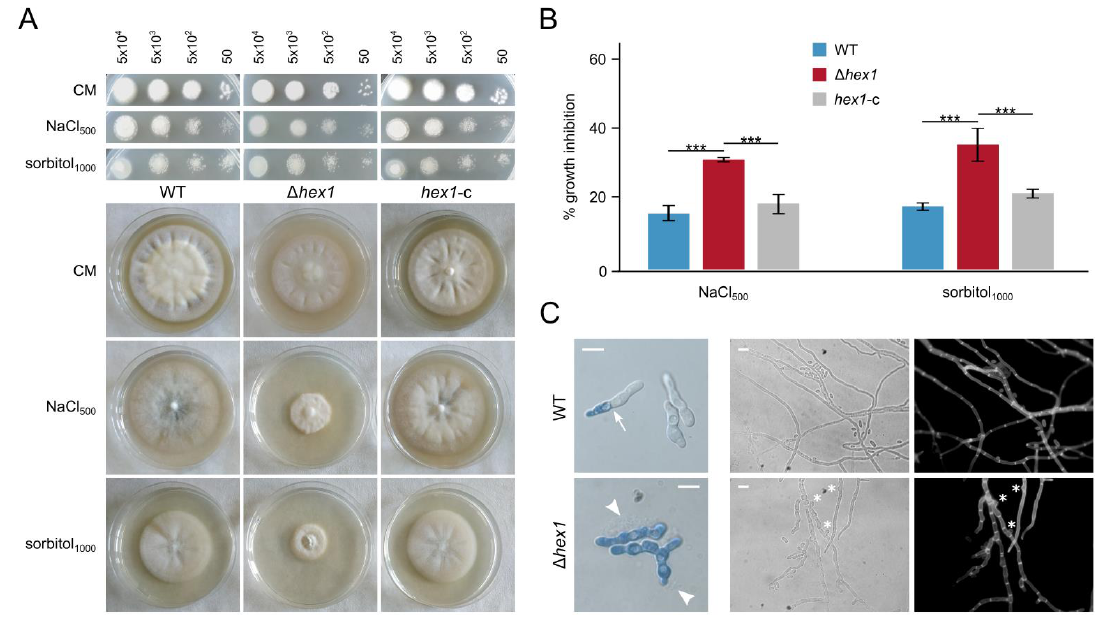
Figure 4. Effects of hyperosmotic stress on Δ hex1 . ( A ) Responses of the wild- type, the deletion (Δ hex1 ), and the complemented ( hex1 -c) strains to NaCl and sorbitol, with regard to germination (top; the number of inoculated conidia per spot are provided above the images; growth for 3 days) and radial growth (bottom; growth for 18 days). CM: CzD-CM. ( B ) Relative growth inhibition by NaCl and sorbitol (each condition was tested in triplicate; bars = SD; statistical testing by one-way ANOVA followed by Tukey’s post hoc test (*** p ≤ 0.001 ). All concentrations are given in mM. ( C ) Staining of wild-type and Δ hex1 germlings with methylene blue, after growth for 16 h in a hyperosmotic medium of 0.5 M NaCl (left). Arrow: septum. Arrowheads: cytoplasmic bleeding. Morphology of corresponding hyphae under the same conditions. Asterisks: “bubble” -like cells. Cell wall staining using calcofluor white M2R. Bar = 10 μm.